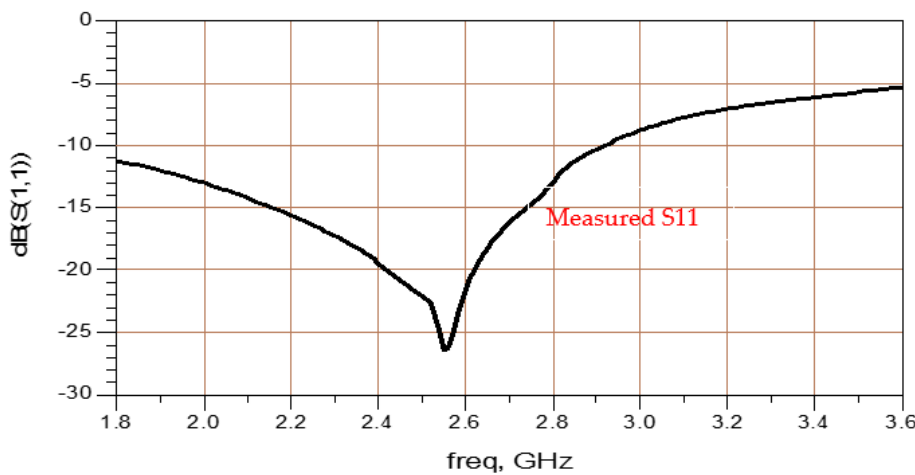
Figure 20. Metamaterial Circular Polarized Transceiver for IoT and medical applications.